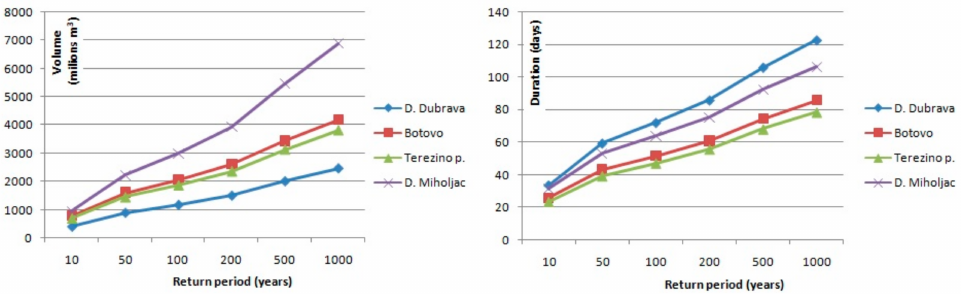
Figure 9. Flood volumes and durations of the Drava River in the Pannonian